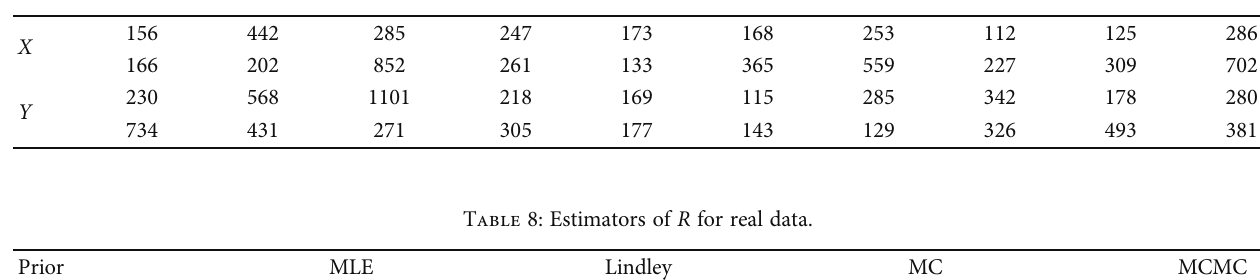
Table 6: L and CP of con fi dence interval for R = 1/3, β